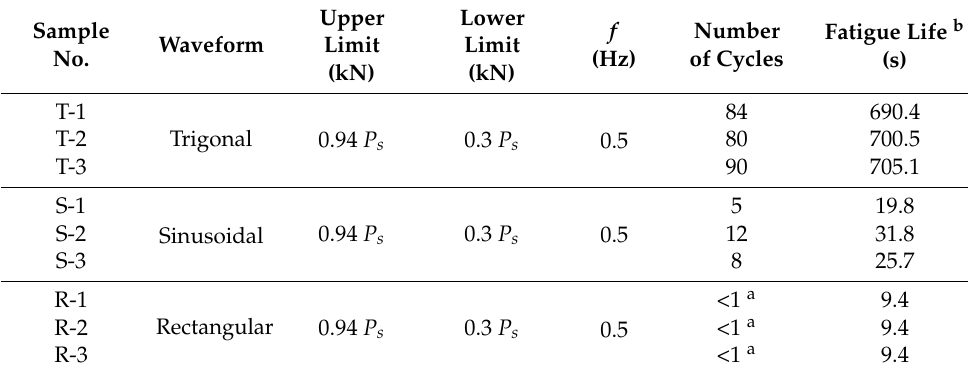
Table 2. Test parameters and results in CPL testing with different